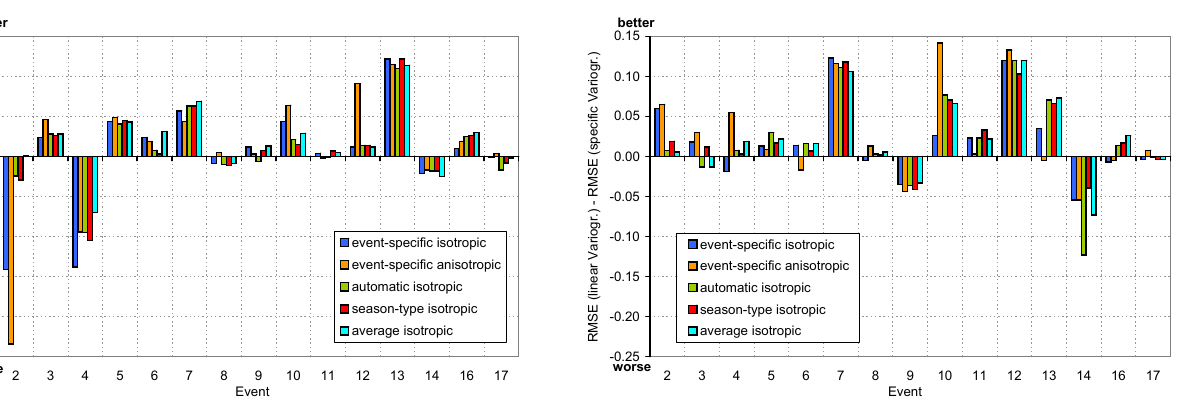
Fig. 5. RMSE difference between the selected variogram type and an “assumed linear” variogram, averaged over time steps with mean precipitation intensity exceeding a threshold of 1.0mmh − 1 . KED with radar rainfall intensities is used for interpolation.